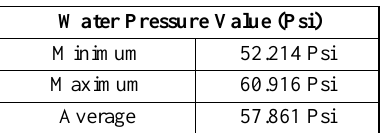
Table 1 . Range of water pressure value if there is no water flow.